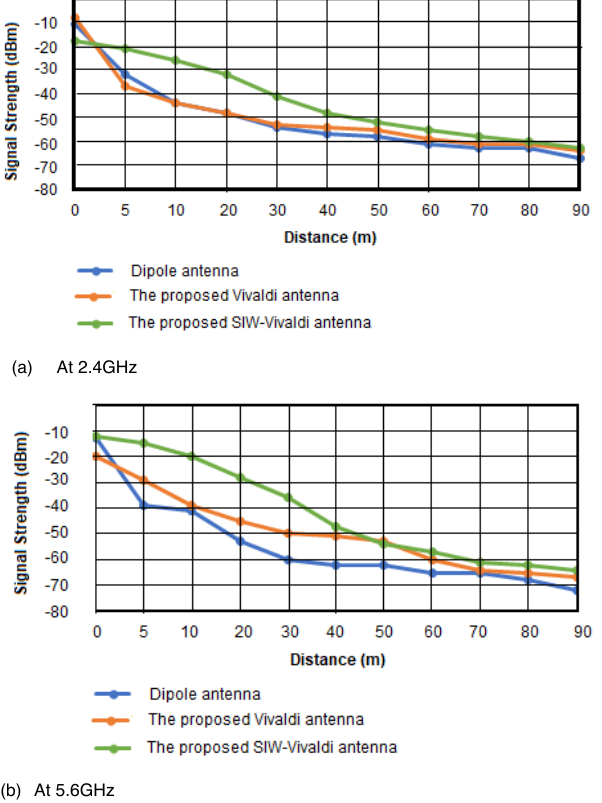
FIGURE 12. The signal strength comparison among dipole antenna and the proposed antenna with and without SIW structure in dry and hot weather.